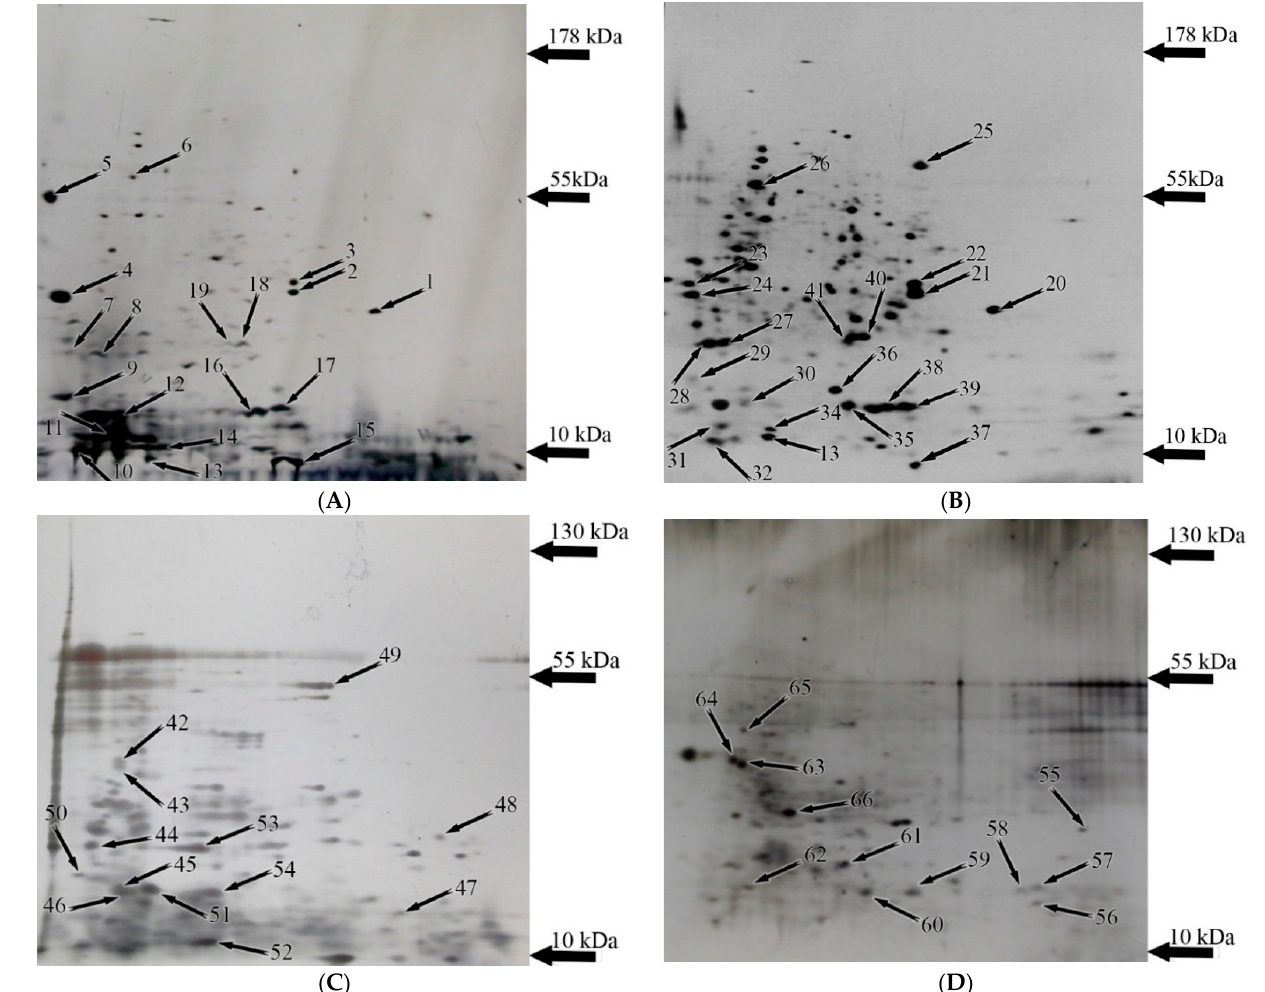
Figure 1. The 2-DE maps of the Y. lipolytica cells prepared with linear wide-range immobilized pH gradients (pH 3–10, 17 cm, BioRad, Hercules, CA, USA) in the first dimension and on 12% SDS-PAGE for the second dimension. Proteins were stained with colloidal Coomassie blue G-250. Labeled by small arrows spots indicate the proteins with the expression changed under various conditions. The conditions were: ( A ) normal; ( B ) alkaline stress; ( C ) heat stress; ( D ) combined stress. All the identified protein spots are numbered according to Table S1. Thick arrows are the markers of molecular mass. Table 1. The expressed proteins identified in the 2-DE map of the Y. lipolytica cells under normal conditions. Spot